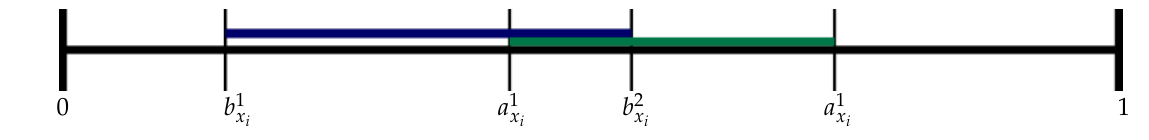
Figure 3. Similarity between agents.